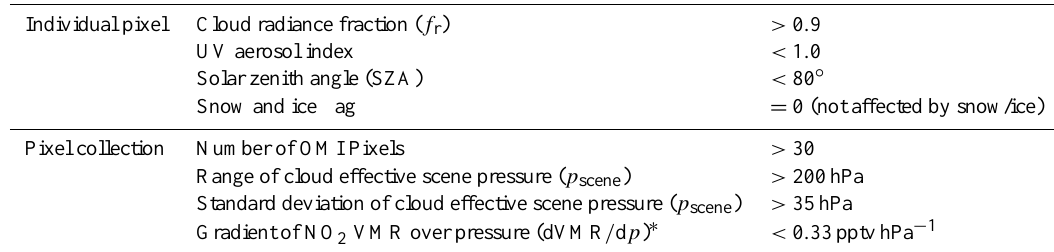
Table 1. OMI data filtering criteria for cloud-slicing approach.